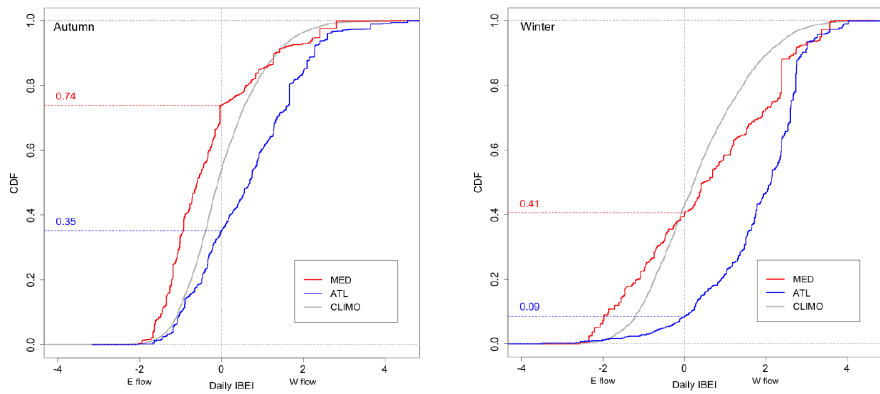
Figure 9.- Seasonal cumulative distribution function for daily values of IBEI. Line colors as in Figure 8.